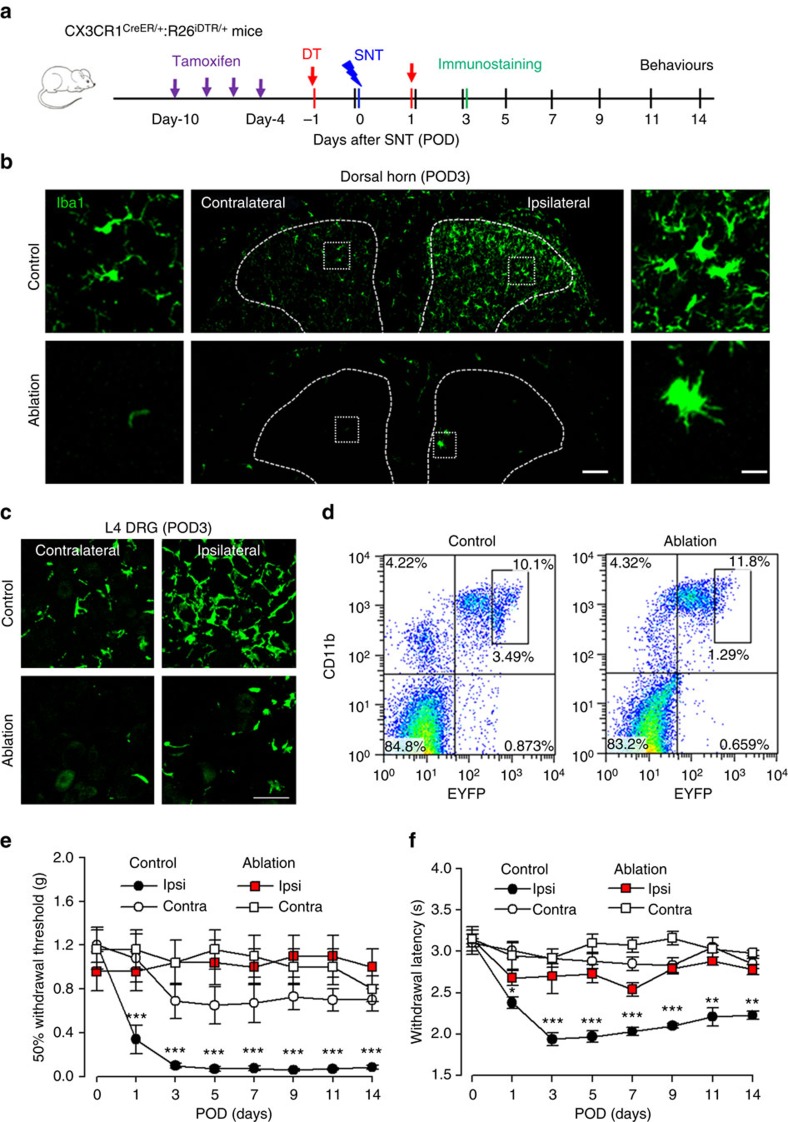
Ablation of CX3CR1+ cell population prevents neuropathic pain development.(a) An experimental diagram showing the timeline of drug treatments, SNT surgery, immunostaining and behavioural tests. (b) Confocal images showing Iba1-positive microglia in the dorsal horn of CX3CR1CreER/+:R26iDTR/+ mice on the ipsilateral and contralateral side at POD3 after SNT in control and ablation mice. Scale bar, 100 μm. Left and right: representative higher-magnification images from boxed regions showing microglial morphology. Scale bar, 20 μm. (c) Representative images of Iba-1-stained macrophages from both contralateral and ipsilateral L4 DRG in ablation and control group. Scale bar, 50 μm. (d) Flow cytometry signatures of blood monocytes depicting CD11b+CX3CR1+ population in ablation and control groups. The CX3CR1 expression level was indicated by intensity of EYFP fluorescence (n=3 for each group). (e,f) Behavioural assays showing mechanical allodynia (e) and thermal hyperalgesia (f) in ablation and control groups. (Data represent mean±s.e.m., n=9 for ablation group and 7 for control groups. ***P<0.001, **P<0.01, ablation ipsi versus control ipsi for both mechanical, U-test, and thermal response, t-test.) CX3CR1CreER/+:R26iDTR/+ mice with DT only were considered to be controls and mice with both TM+DT treatment was ablation group.